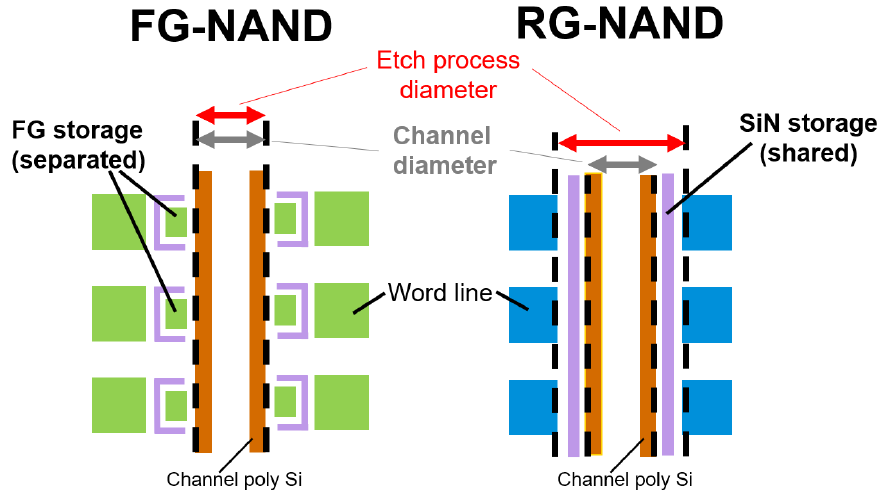
Figure 5. Cross-section comparison of NAND strings between floating gate (FG) NAND and re- placement gate (RG) NAND. RG NAND has a larger diameter for the memory hole etching which is advantageous for the pillar height scaling.